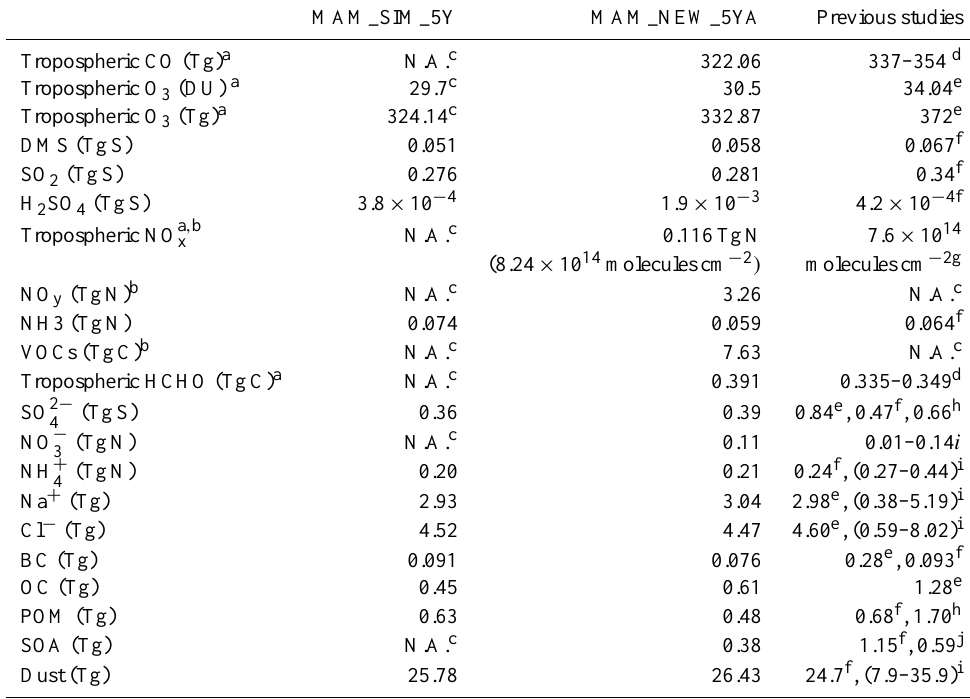
Table 7. Global Burdens of Major Gaseous and Aerosol Species from the 2001–2005